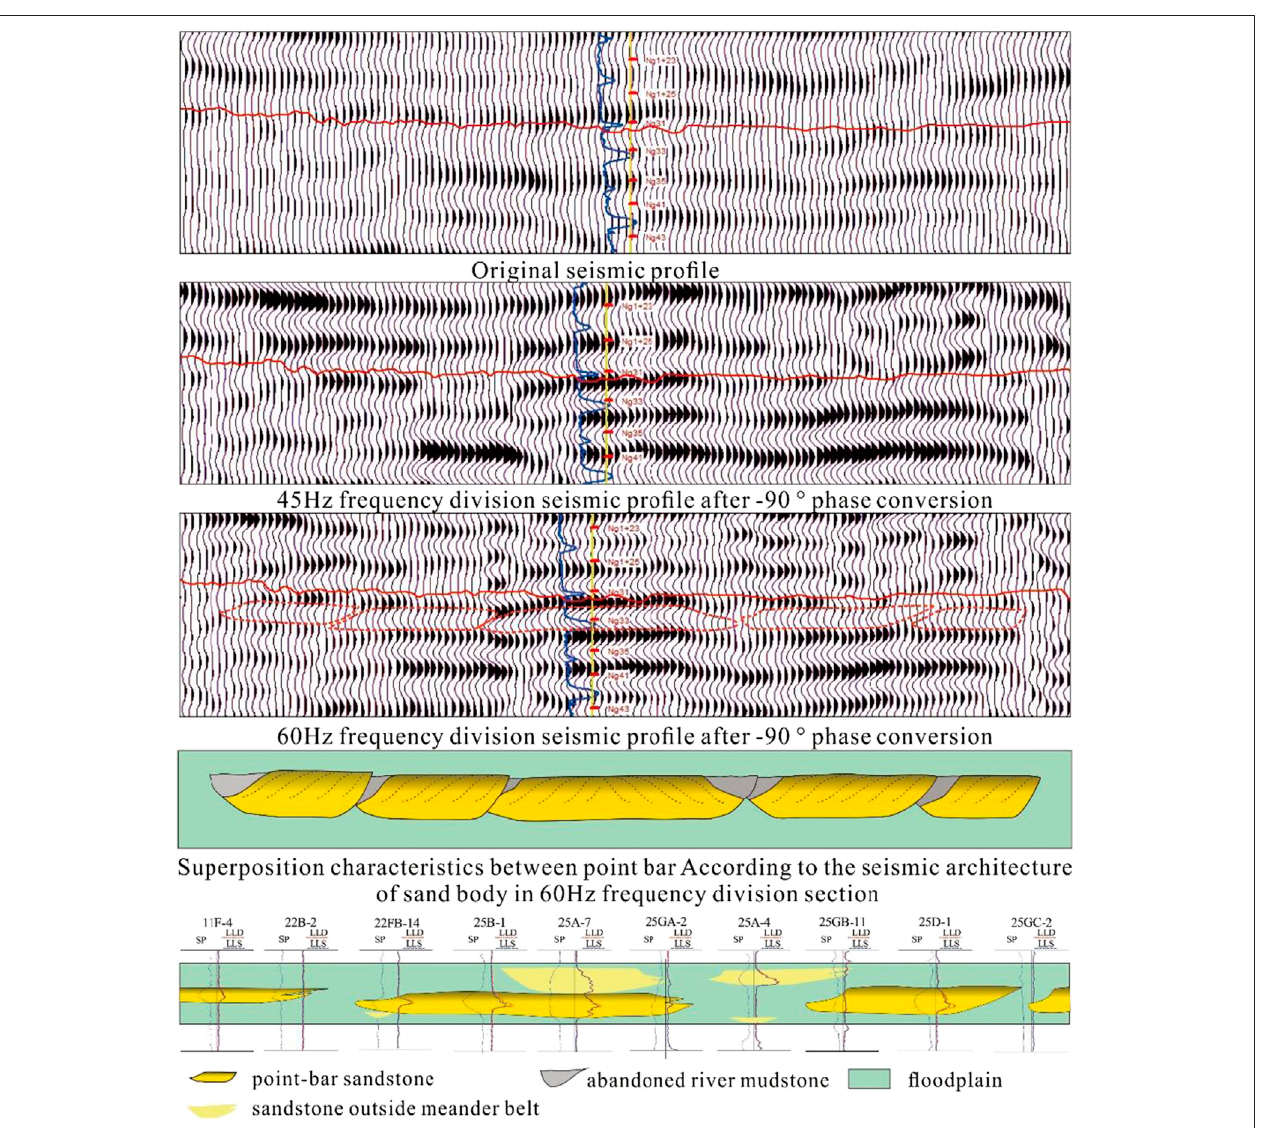
FIGURE 8 | Architectural characteristics of typical point bar in Ng33 sub-layer, seismic and logging interpretation pro fi le, and results. Interpretation of point bars in meander-river belt of Ng42 sub-layer.